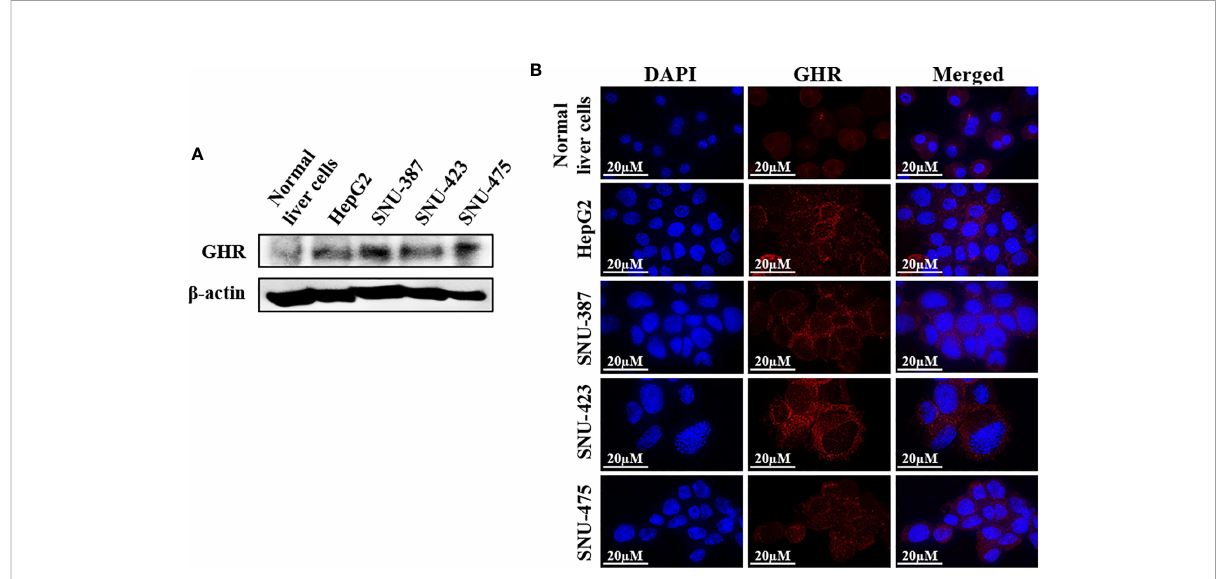
FIGURE 3 Expression of GHR in HCC cell lines. Western blotting (A) and immuno fl uorescence staining (B) demonstrate the expression of GHR in the cell lines HepG2, SNU-387, SNU-423, and SNU-475. The expression of GHR was markedly more pronounced in HCC cells than in normal human liver